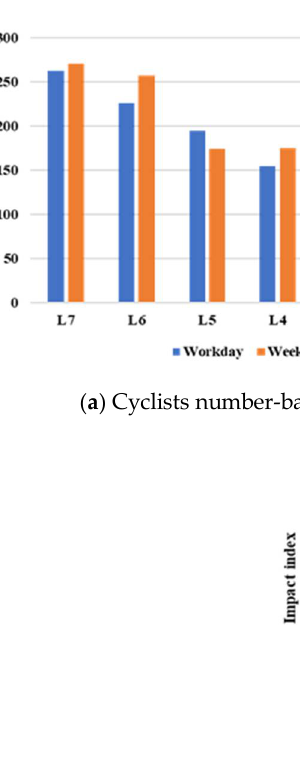
Figure 9. Riding distance-based impact analysis result.